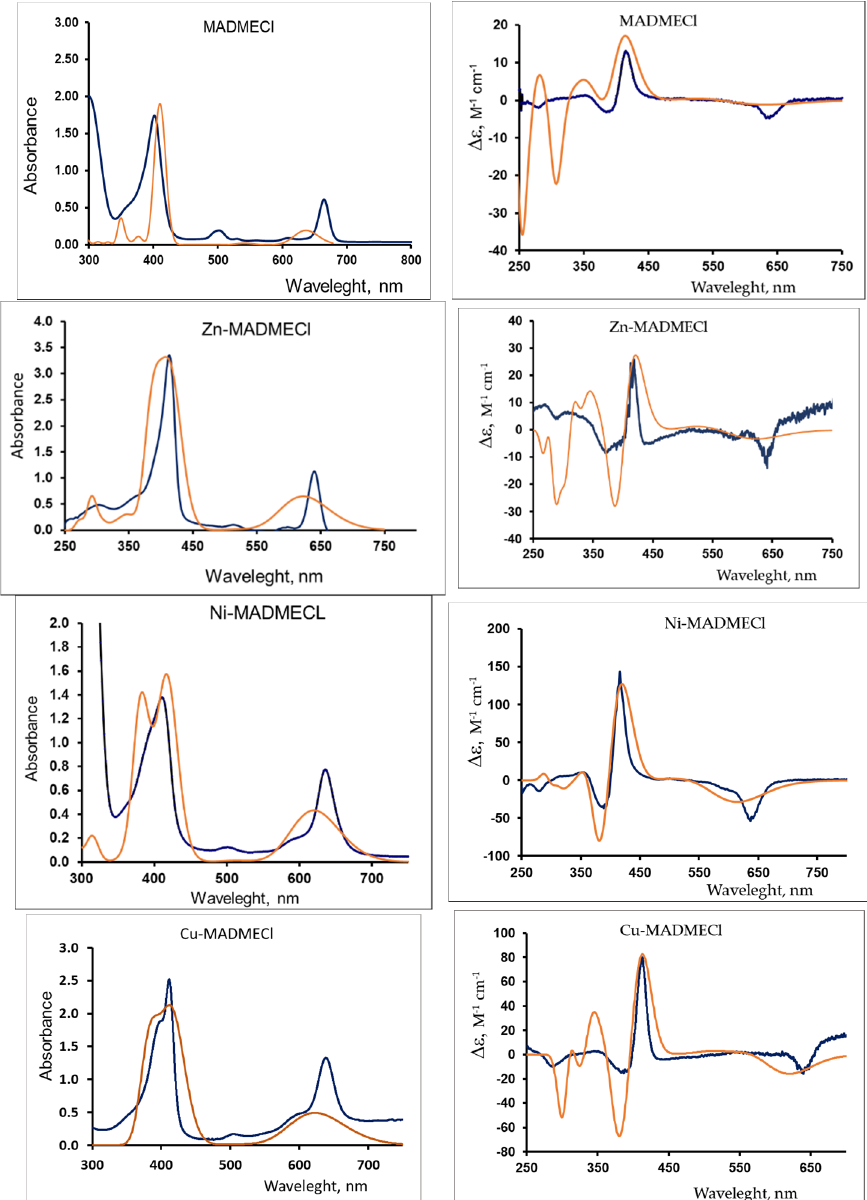
Figure 1. UV/Vis spectra ( left ) and CD spectra ( right ). Blue—experimental (chloroform, С MADMECl = 1.5·10 − 4 M, С Zn-MADMECl = 3.2·10 − 5 M, С Cu-MADMECl = 1 . 3·10 − 4 M, С Ni-MADMECl = 1.1·10 − 4 M); orange—calculated (TDDFT PCM-chloroform, n = 25).